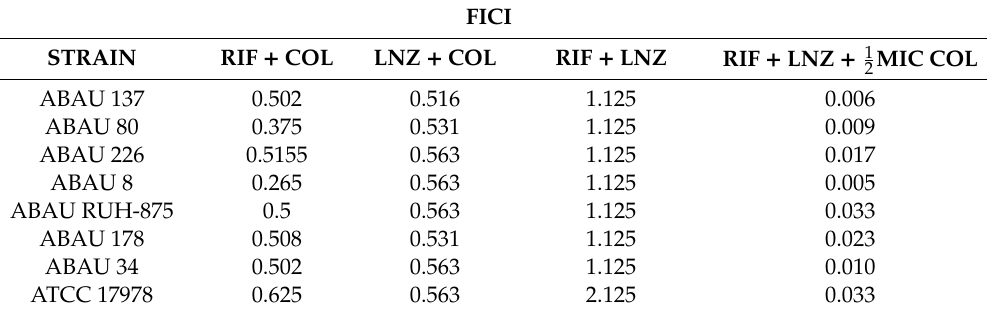
Table 6. Checkerboards of the di ff erent antibiotics used with their FICIs in MDR A. baumannii